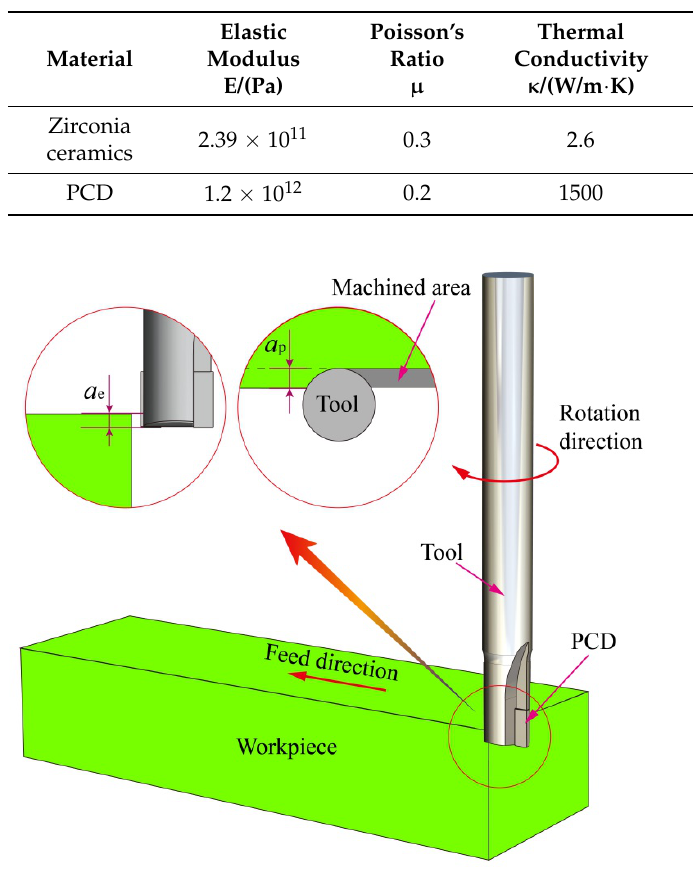
Table 2. Physical properties of workpiece and tool.